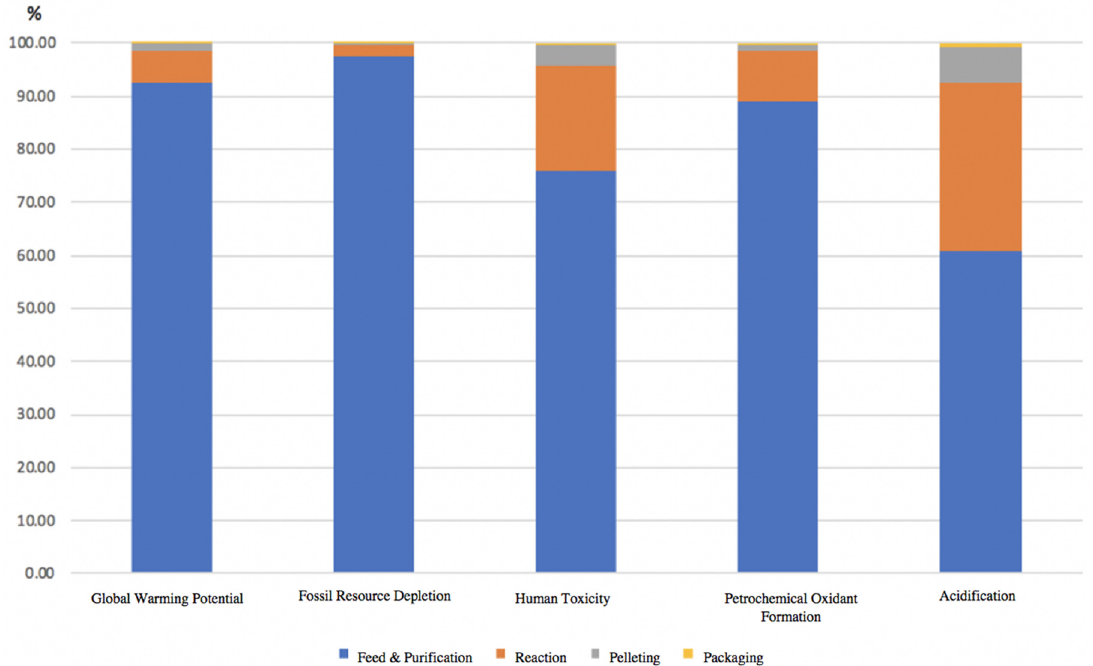
Figure 4. An overview for the impact assessment categories results for annual production of PP, representing the results for each process in the PP manufacturing plant, including the feed and purification phase.